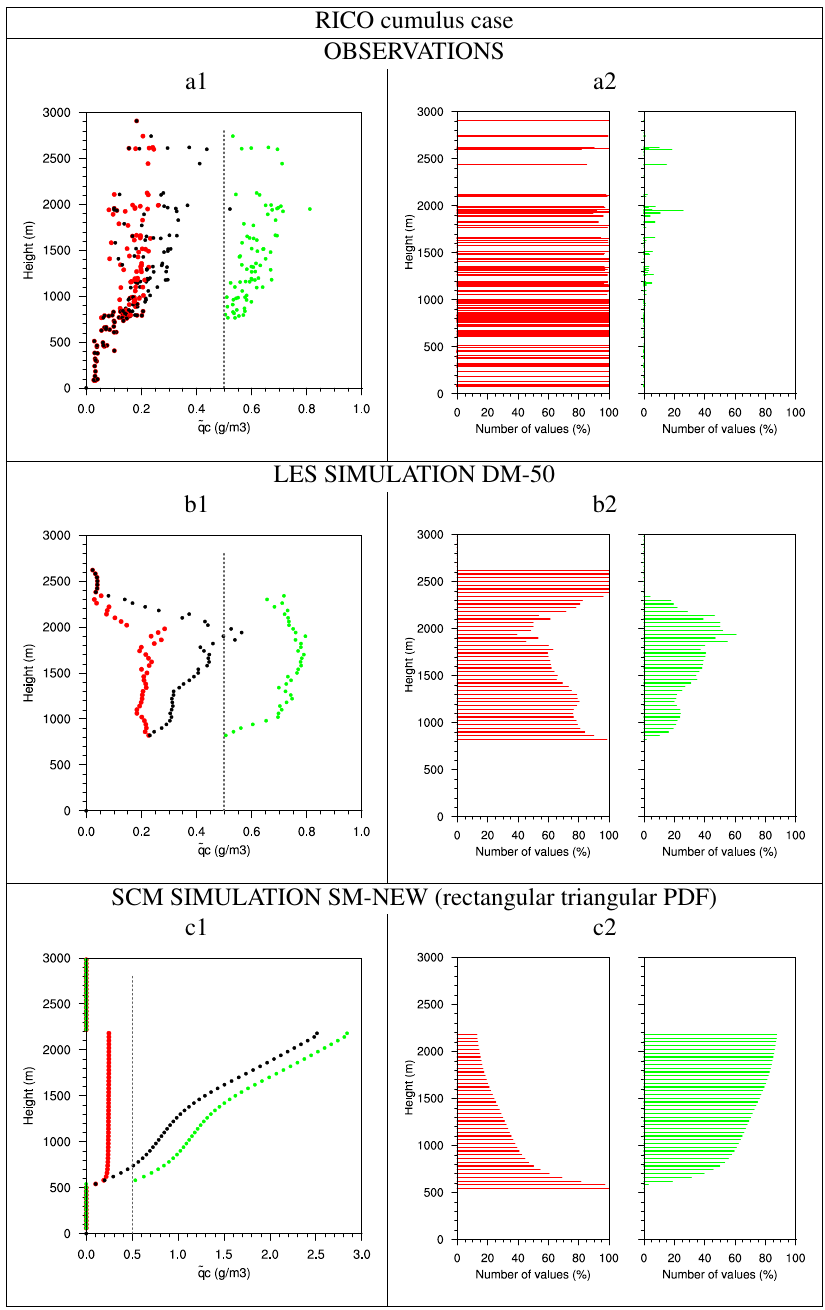
Figure 14: Same as Fig. 9 for RICO. Fig. 14. Same as Fig. 9 for